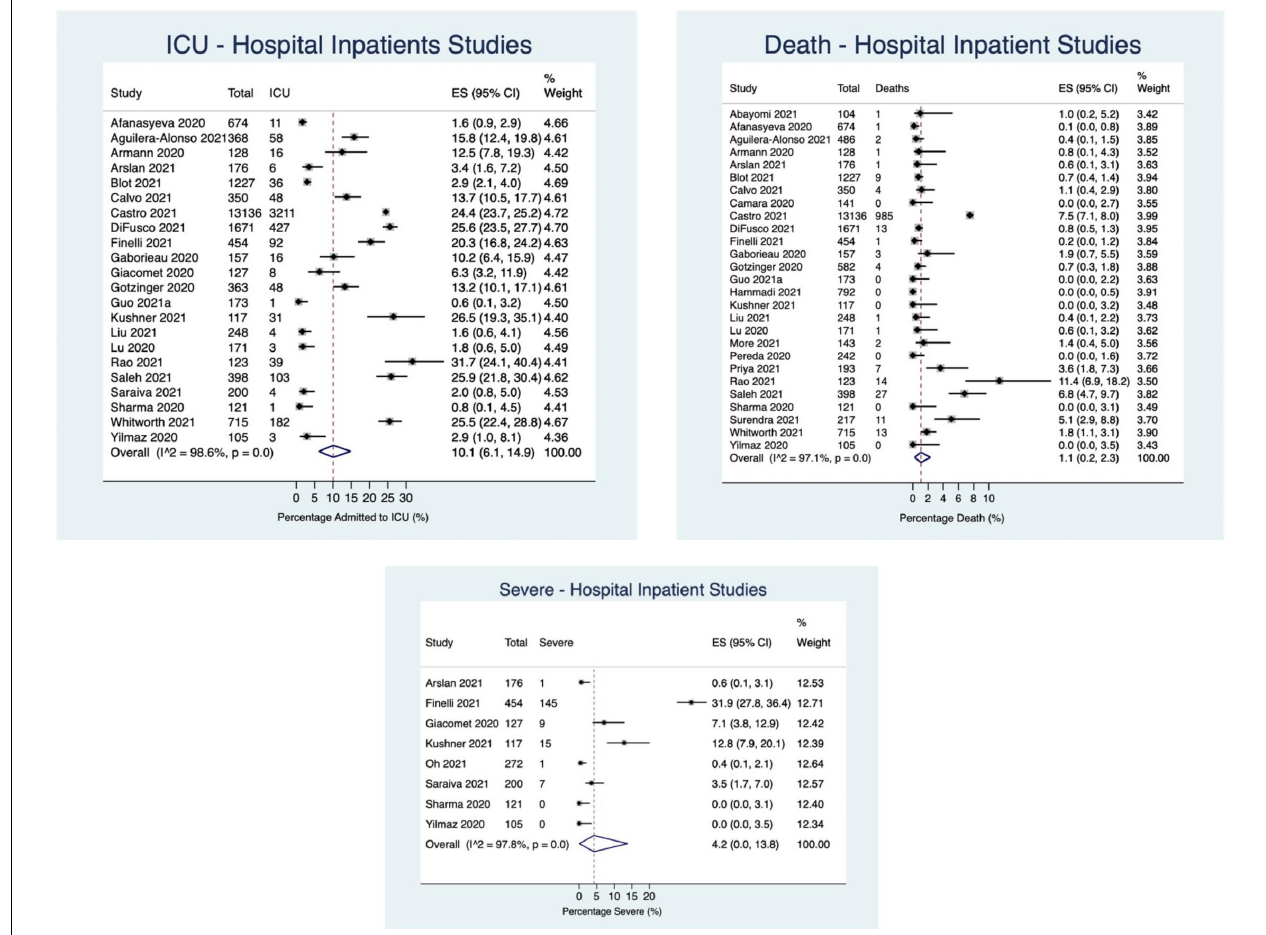
FIGURE 6 | Percentage of children experiencing outcomes in hospital inpatient